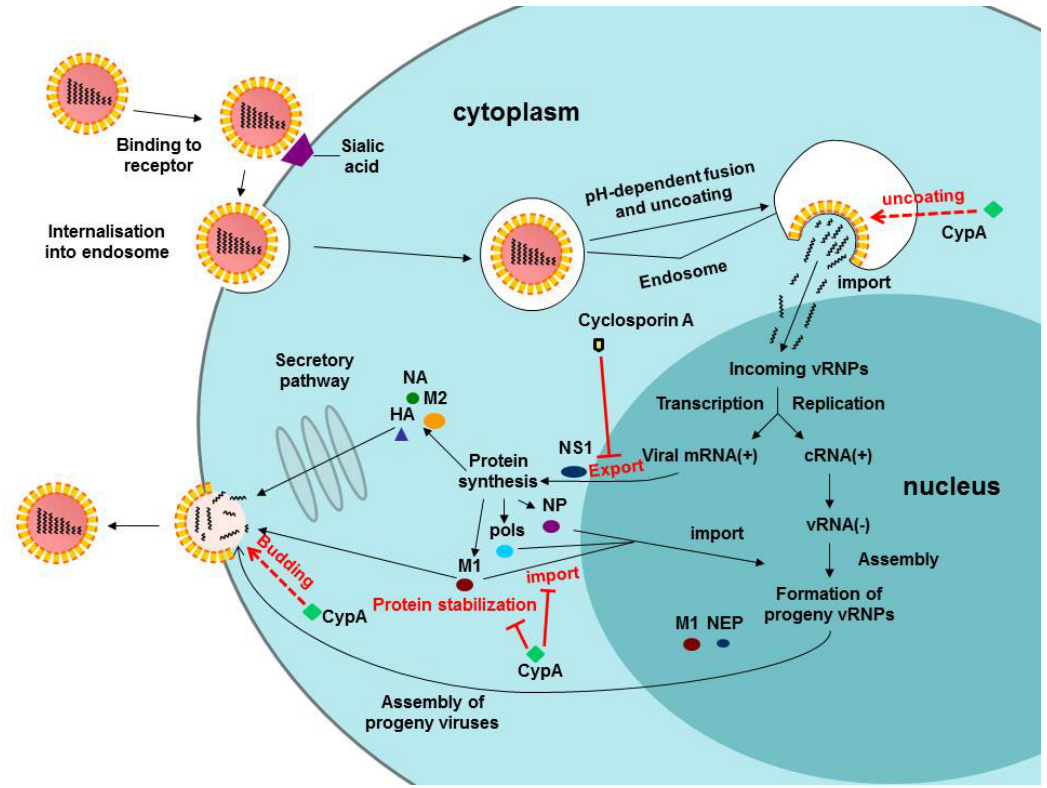
Figure 1. The functions of CypA in the lifecycle of influenza